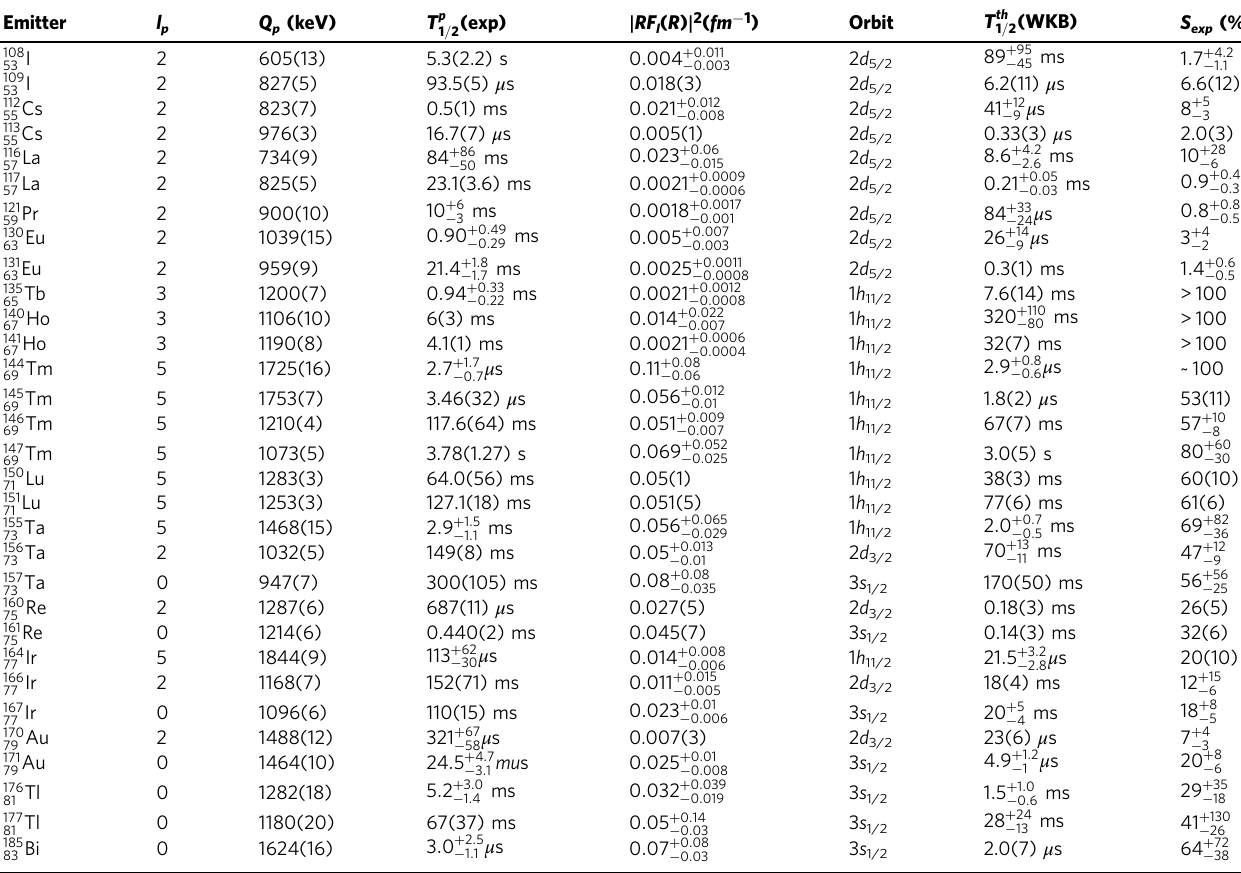
Table 1 Calculated proton formation probabilities and spectroscopic factors for the ground-state proton emitters.